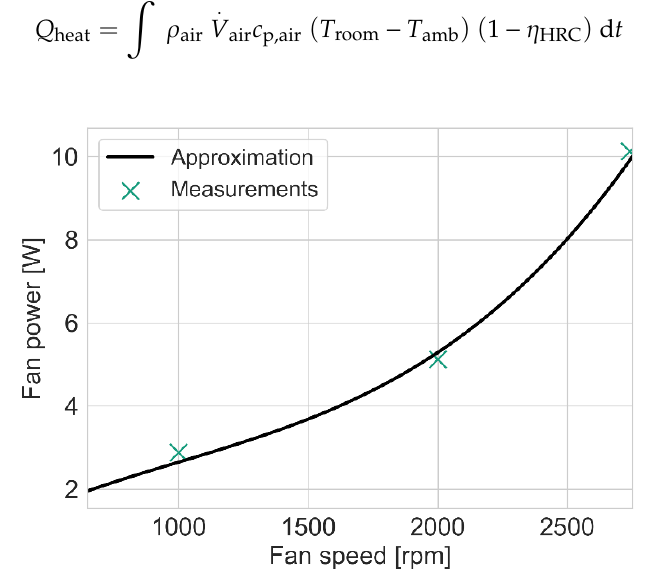
Figure 13. Fan power as a function of the fan speed [27].